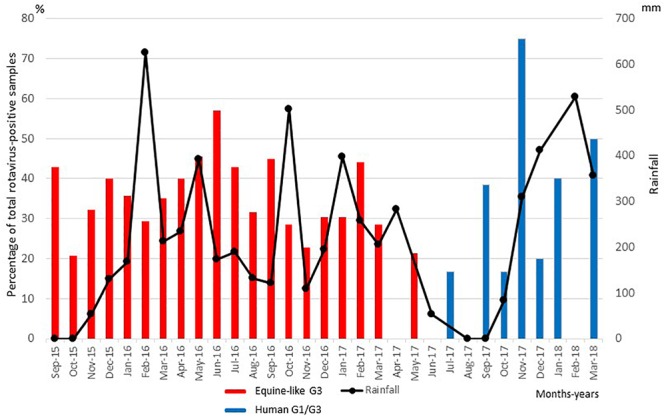
Distribution of equine-like G3P[8]/P[6] (black columns) and global G1/G3P[8]/[6] (gray columns) rotavirus strains collected in East Java, Indonesia, between September 2015 and March 2018. Numbers of rotavirus-positive samples are expressed as percentages of total rotavirus-positive samples in each month of the sampling period.